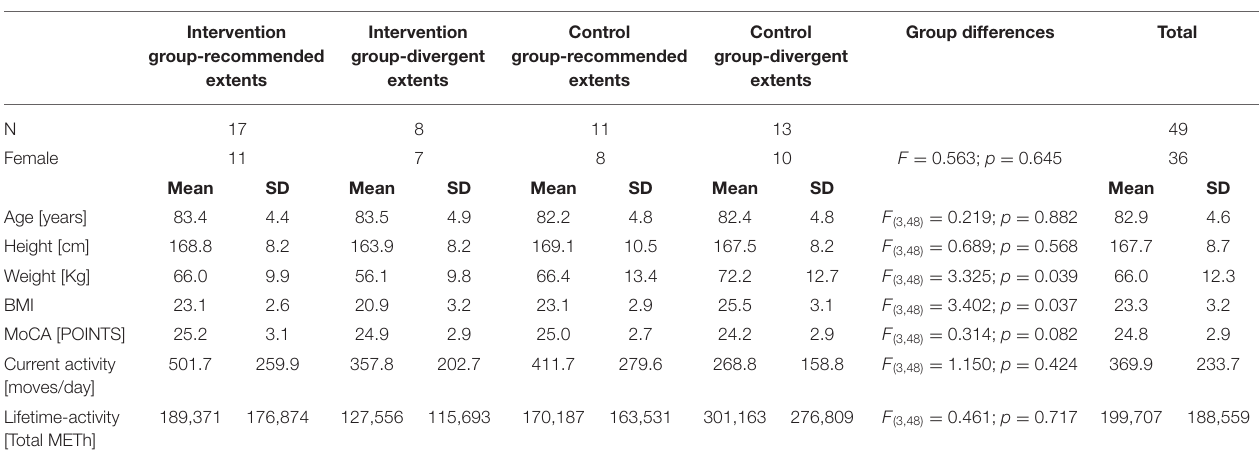
TABLE 2 | Baseline demographic